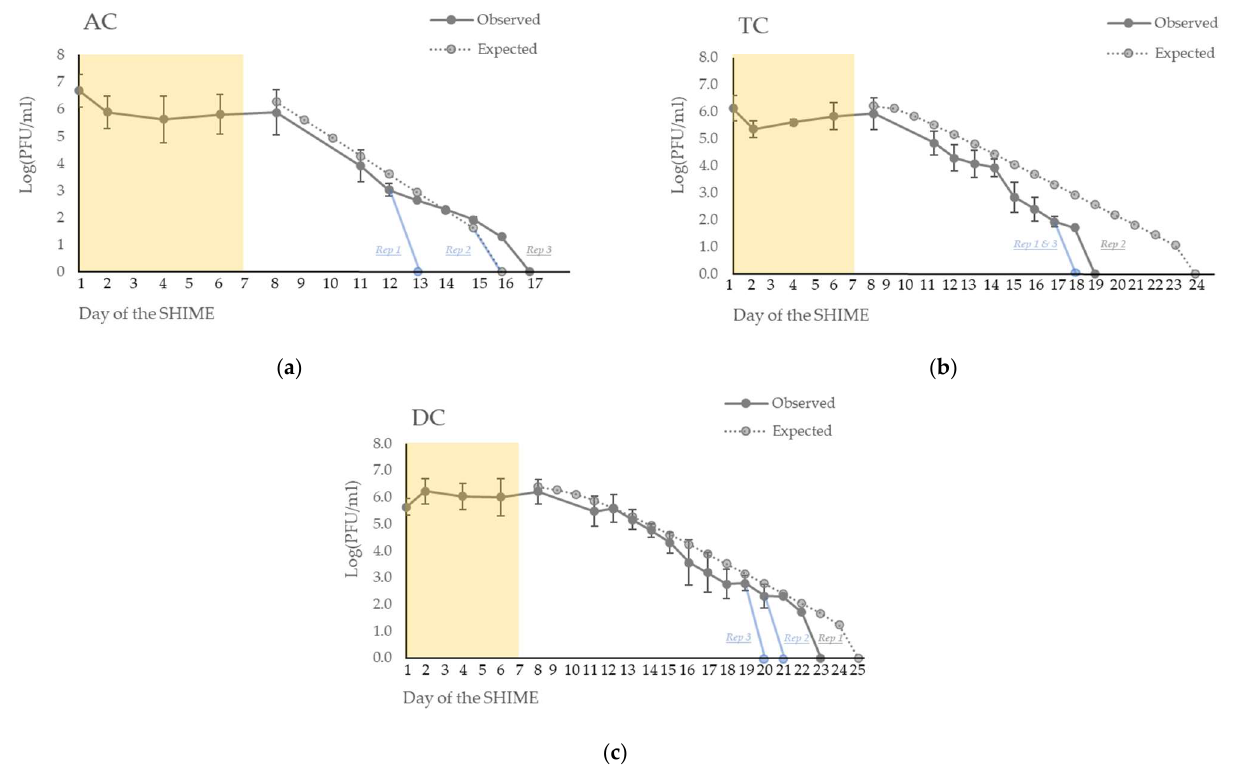
Figure 3. Persistence of the phage ULIP33 in ascending (AC) ( a ), transverse (TC) ( b ) and descending (DC) ( c ) colons in the SHIME ® model after one daily phage injection (10 mL at 10 9 PFU/mL) in the ascending colon for 7 days. The mean concentrations (±SD) are presented in log (PFU/mL) for the observed data of the phage titrations (dark gray curves). The expected phage titrations (based on the mathematical model; dotted gray curve) are calculated based on the observed titrations of the phage at day 8. The yellow frame represents the phage treatment week; blue curves represent the fastest disappearance in the different repetitions.